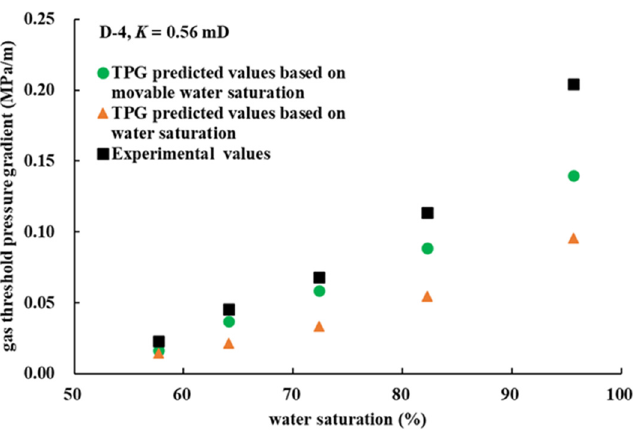
Figure 10. TPG predicted values versus experimental values of core plug D-4.